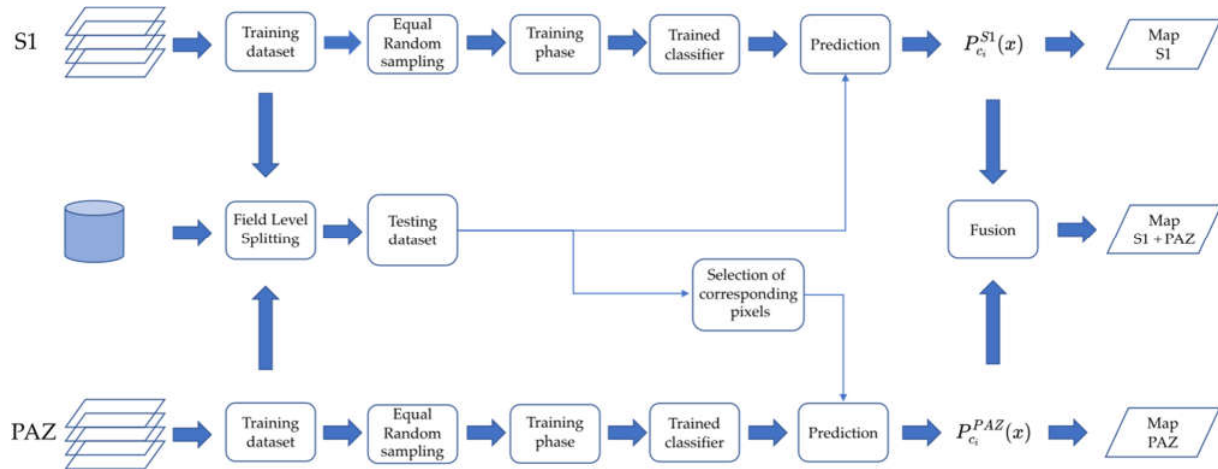
Figure 3. Classification methodology flowchart .